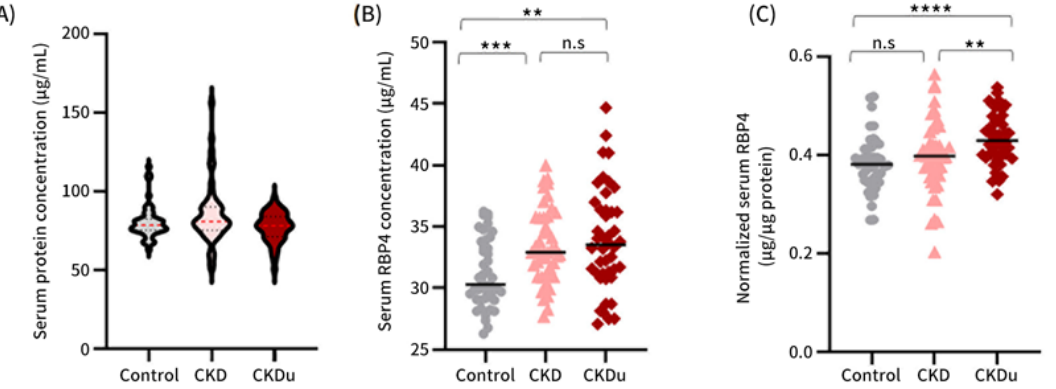
Figure 2. Sera protein and serum RBP4 level. ( A ) Violin plot showing distribution of sera protein levels in control and diseased cohorts. ( B , C ) Boxplots showing distribution of RBP4 in control and diseased cohorts; ** p < 0.01, *** p < 0.001, **** p < 0.0001, n.s = not